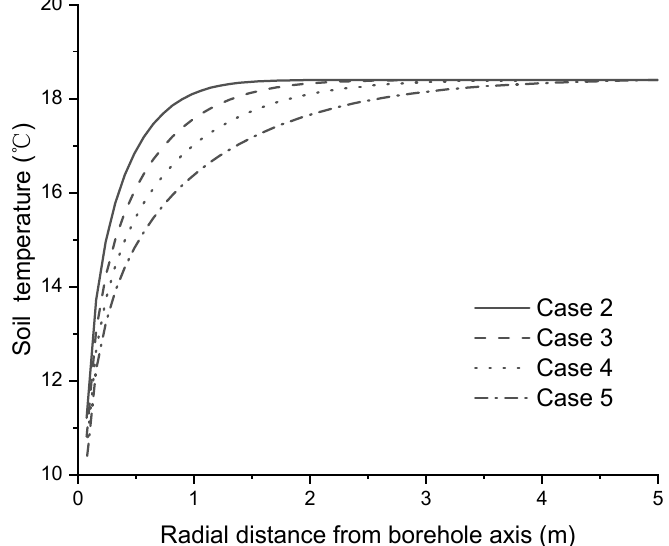
Figure 3. The distribution of soil temperature at the beginning of the discharging process under different precooling times.